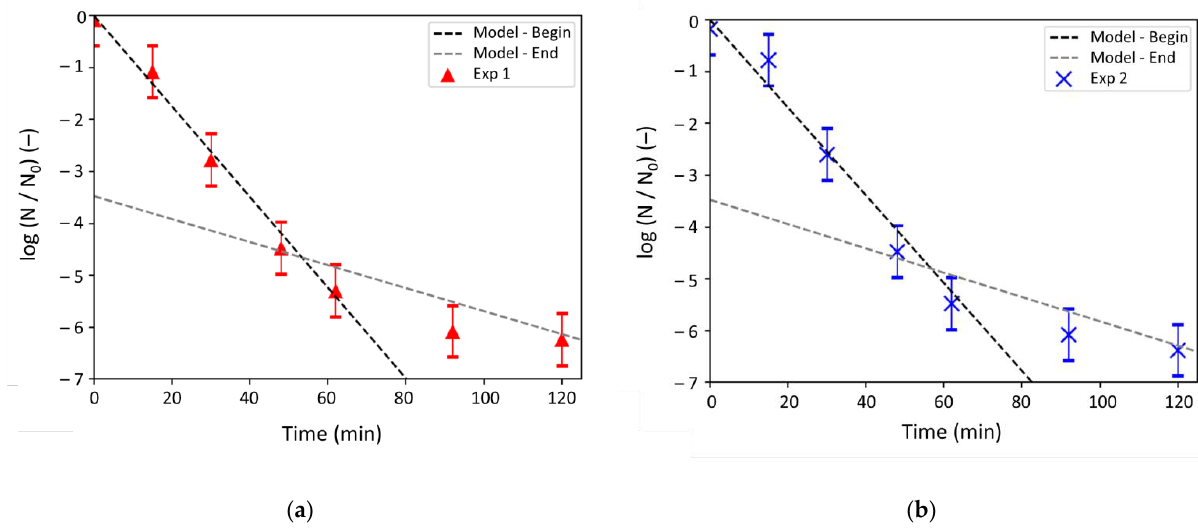
Figure 7. Log-removal values over time: model vs. experiment for ( a ) experiment 1 and ( b ) experiment 2. Model-Begin designates the model proposed over the first 60 min of experience while Model-End refers to the one from 60 min.